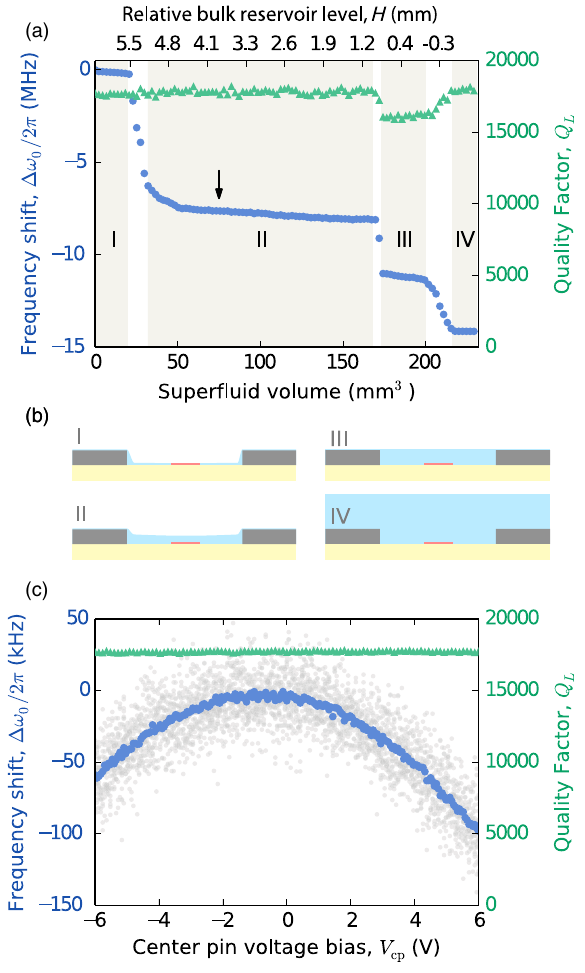
FIG. 2. Cavity response to superfluid helium. (a) Measured resonance frequency shifts Δ ω 0 = 2 π (blue dots, left axis) and loaded quality factor Q (green triangles, right axis) as functions L of superfluid volume supplied to the cell (bottom axis) and relative bulk helium level H in the reservoir (top axis). Each data ∼ point corresponds to an increase in superfluid volume of Δ V sf 2 . 3 mm 3 and reservoir level Δ H ∼ 70 μ m. (b) Different filling state corresponding to the different regimes in (a). (c) Frequency shift (blue dots, left axis) and quality factor (green triangles, right axis) as functions of center pin voltage bias V at fixed helium cp level in the capillary action regime indicated by arrow in (a). Gray dots are frequency shifts extracted from single-shot cavity transmission measurements with N ¼ 80 such measurements per voltage bias point V . The blue data points are averages cp over the single-shot measurements at each